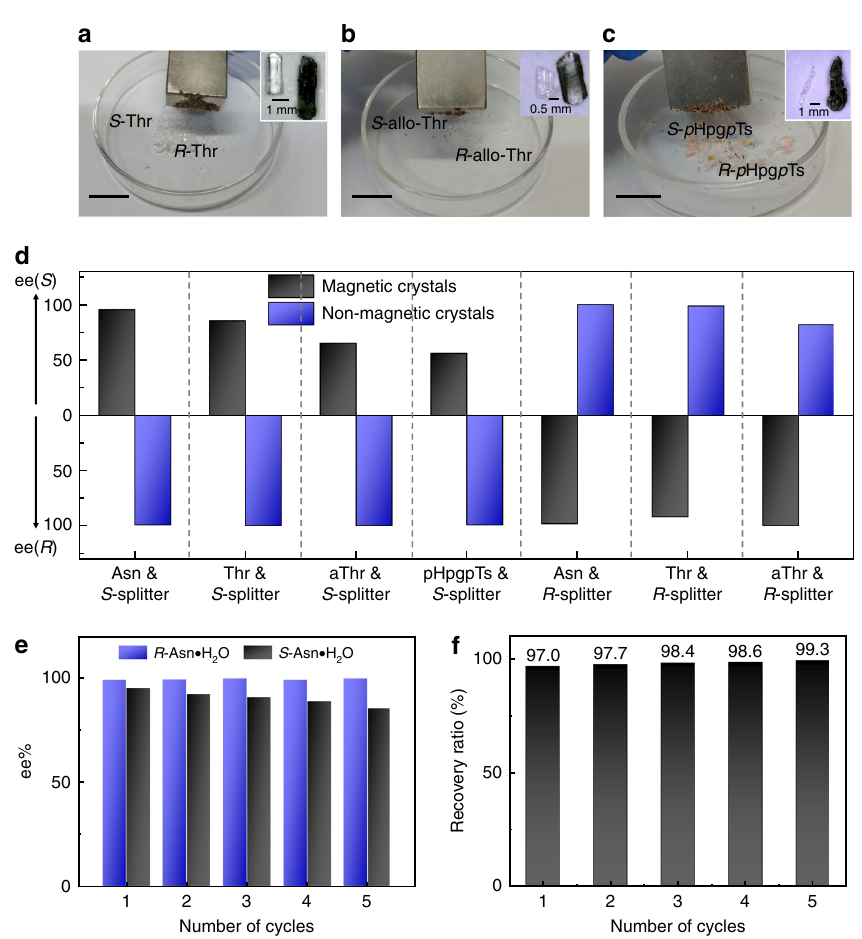
Fig. 4 Extension of this strategy and the recyclability. a The typical photo of S and R -Thr crystals in the present of S -Fe-25 – 125. b The typical photo of S and R -aThr in the present of S -Fe-25 – 125. c The typical photo of S and R - p Hpg p Ts in the present of S -Fe(PMPA)-45 – 115. d The ee% values for both R and S - crystals in different systems. e The crystallization results by using recycled S -Fe-25 – 125. f The recovery ratio of S -Fe-25 – 125 for each cycle. Scale bars: 2